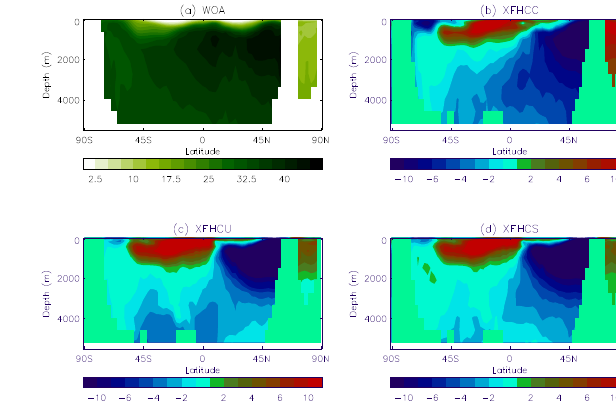
Fig. 16. As for Fig. 15 but for the Atlantic basin (70 ◦ W–20 ◦ E).